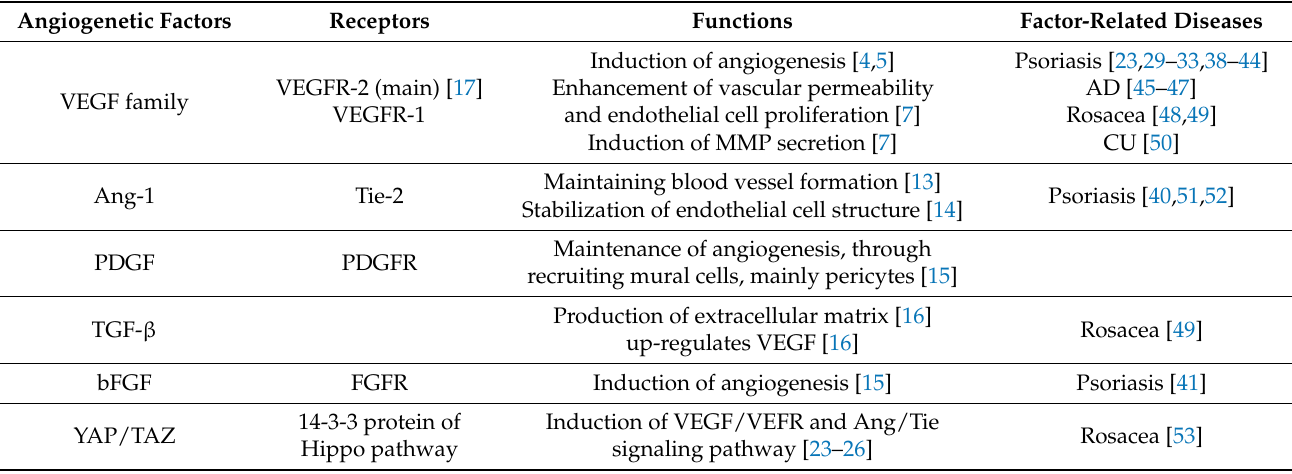
Table 1. Angiogenetic factors, their receptor and functions, and related diseases. VEGF, vascular endothelial growth factor; VEGFR, vascular endothelial growth factor receptor; MMP, matrix-metalloproteinase; AD, atopic dermatitis; CU, chronic ur- ticaria; Ang, angiopoietin; Tie, TEK receptor tyrosine kinase; PDGF, platelet-derived growth factor; PDGFR, platelet-derived growth factor receptor; TGF- β , transforming growth factor- β ; EphR, Erythroprotein-producing human hepatocellular carcinoma receptors; YAP, Yes-associated protein 1; TAZ, Transcriptional co-activator with PDZ-binding motif. Angiogenetic